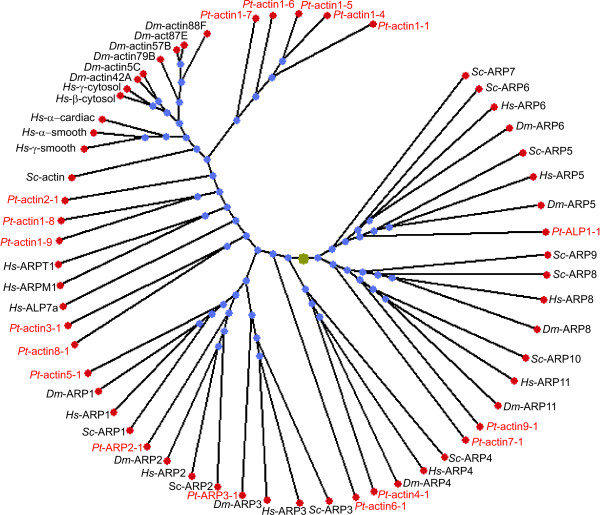
Phylogenetic tree of actins and ARPs. This encompasses Drosophila melanogaster actin42A [GenBank:CG12051], actin57B [GenBank:Q53501], actin5C [GenBank:Q6YN46], actin79B [GenBank:P02574], actin87E [GenBank:Q8MZ23], actin88F [GenBank:P83967], ARP1 [GenBank:P45889], ARP2 [GenBank:P45888], ARP3 [GenBank:P32392], ARP4 [GenBank:Q9V814], ARP6 [GenBank:P83967], ARP11 [GenBank:Q9VWE8], ARP8 [GenBank:Q9VX09], ARP11 [GenBank:Q9VWE8]; Homo sapiens cardiac α-actin [GenBank:P04270], smooth α-actin [GenBank:P03996], cytosol. β-actin [GenBank:P60709], cytosol. γ-actin [GenBank:AAH15779], smooth γ-actin [GenBank:P12718], ARP1 [GenBank:P61163], ARP2 [GenBank:P61160], ARP3 [GenBank:AAH44590], ARP4 [GenBank:O96019], ARP5 [GenBank:Q8IUY5], ARP6 [GenBank:Q9GZN1], ARP8 [GenBank:Q9H981], ARP11 [GenBank:Q9NZ32], ARPM1 [GenBank:Q9BYD9], ARPT1 [GenBank:Q96L10], ALP7β [GenBank:Q9Y614]; Paramecium tetraurelia act1-1 [GenBank:CAD60960], act1-4 [GenBank:CAD60963], act1-5 [GenBank:CAH69678], act1-6 [GenBank:CAH03399], act1-7 [GenBank:CAH69677], act1-8 [GenBank:CAH69676], act1-9 [GenBank:CAH69752], act2-1 [GenBank:CAD60964], act3-1 [GenBank:CAD60966], act4-1 [GenBank:CAH69675], act5-1(arp1-1) [GenBank:CAH69674], act6-1 [GenBank:CAH69671], act7-1 (arp4-1) GenBank:CAH74221], act8-1 [GenBank:CAH03397], act9-1 (arp10) [GenBank:CAH69669], alp1-1 (arp5) [GenBank:CAH69680], arp2-1 [GenBank:CAH69679], arp3-1 [GenBank:CAH74222]; Saccharomyces cerevisiae actin [GenBank:P60010], ARP1 [GenBank:P38696], ARP2 [GenBank:P32381], ARP3 [GenBank:P47117], ARP4 [GenBank:P80428], ARP5 [GenBank:P53946], ARP6 [GenBank:Q12509], ARP7 [GenBank:Q12406], ARP8 [GenBank:Q12386], ARP9 [GenBank:Q05123], ARP10 [GenBank:Q04549]